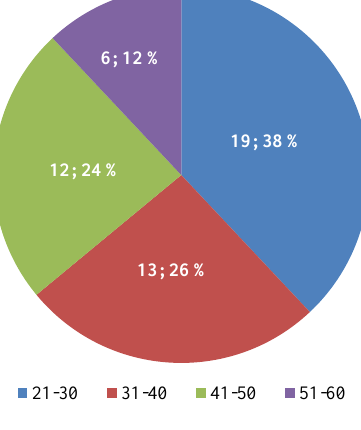
Fig. 4. Age of respondents.